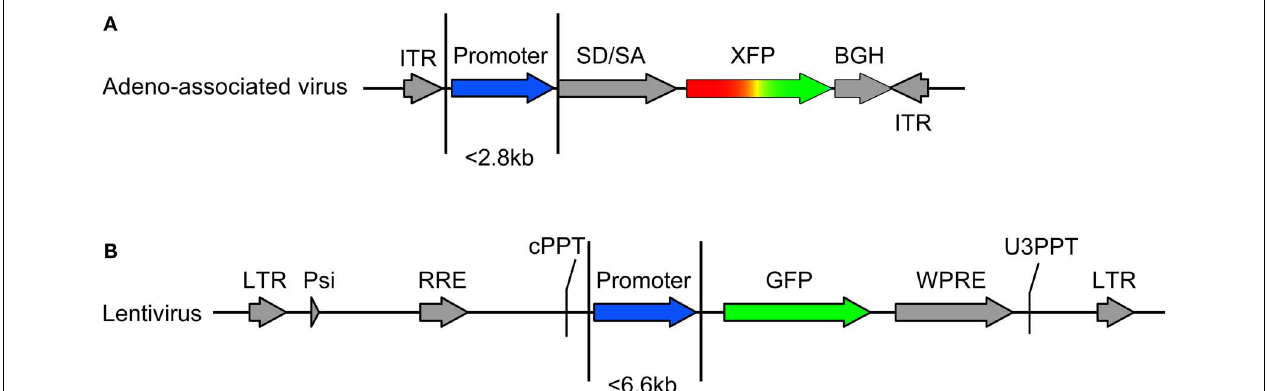
splice donor splice acceptor intronic element (human beta globin), XFP –either GFP or RFP, BGH – poly(A). Components of LV include: LTR – long